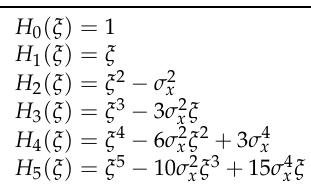
Table 1. Hermite polynomials of variance σ 2 x